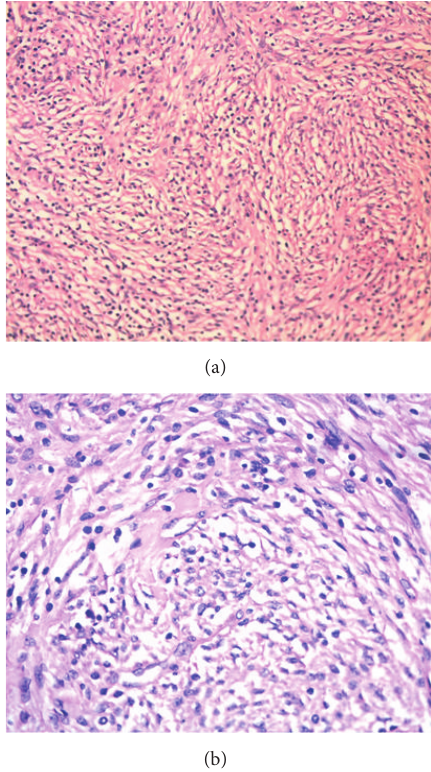
Figure3:Circumscribedspindlecelltumorcomposedofinterlacing fascicles with storiform pattern and sprinkling of lymphocytes on